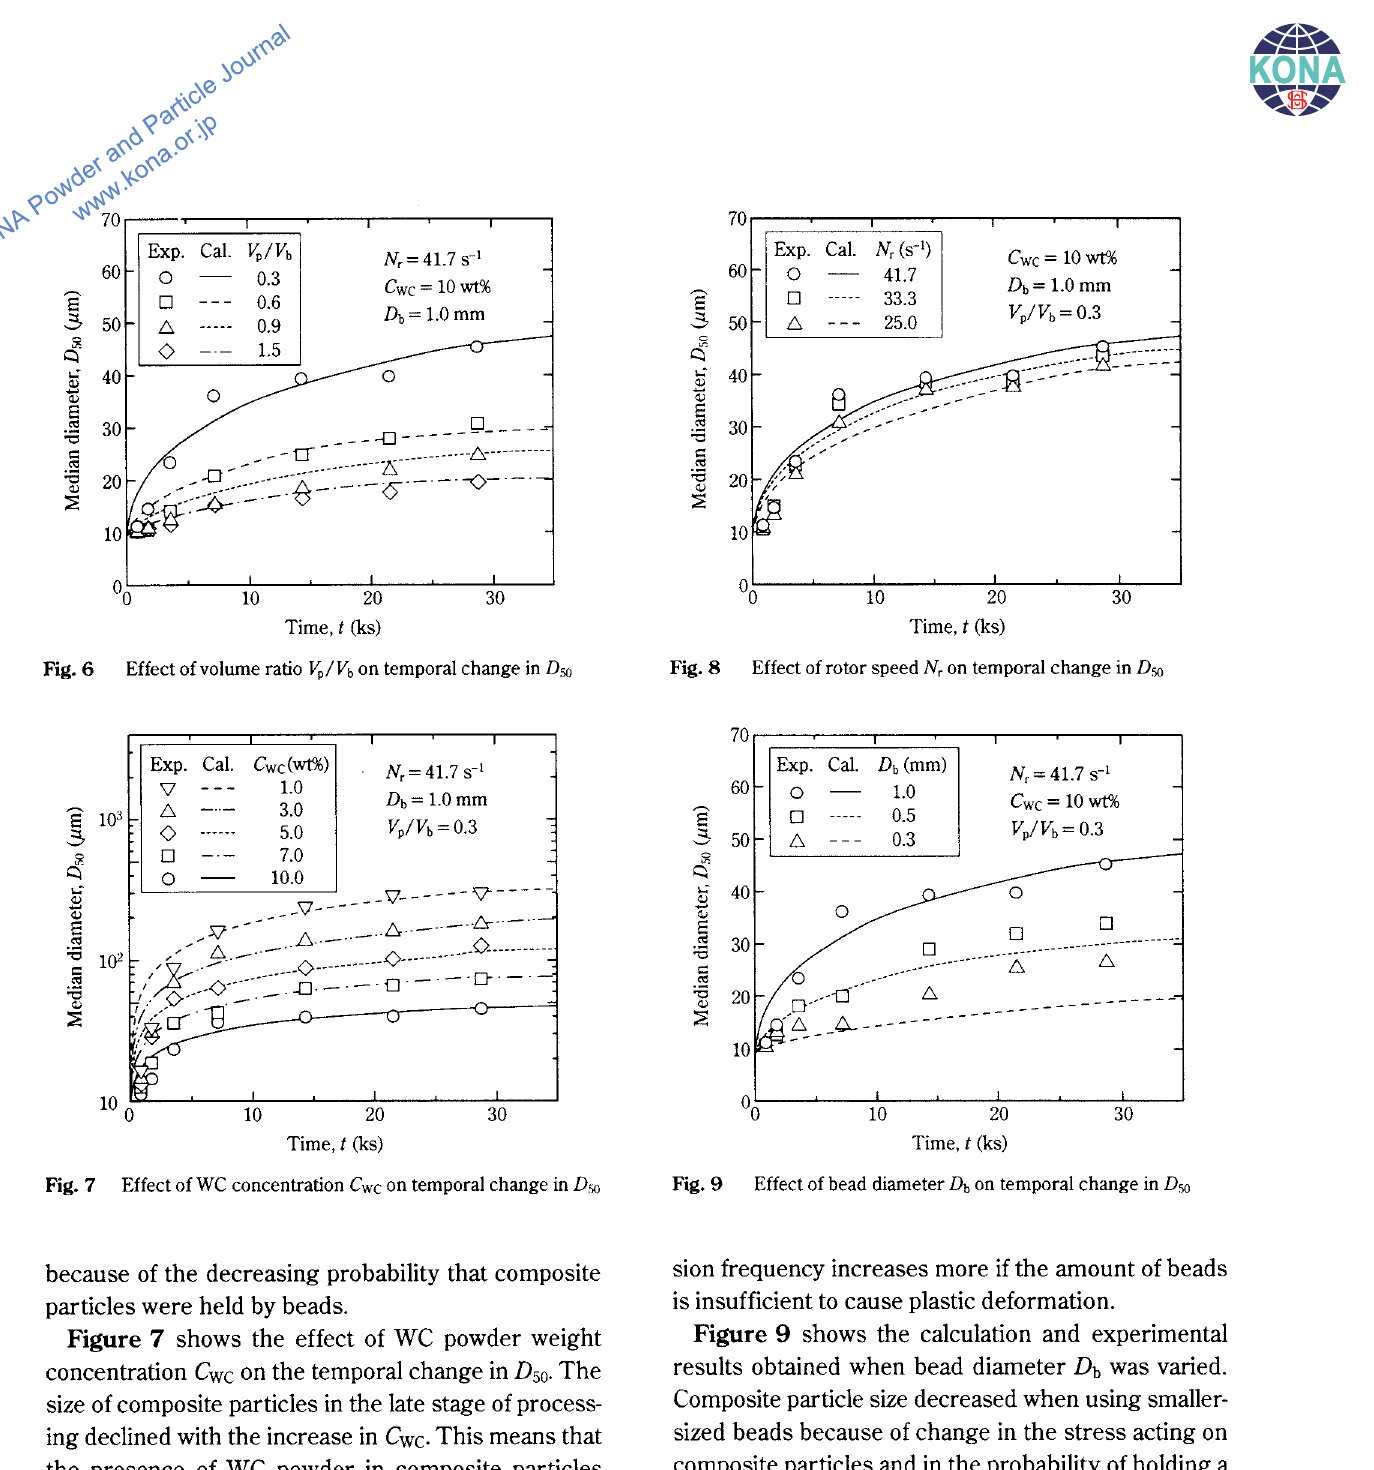
Fig. 7 Effect ofWC concentration Cwc on temporal change in D. 50 Fig. 9 Effect of bead diameter Db on temporal change in D 50